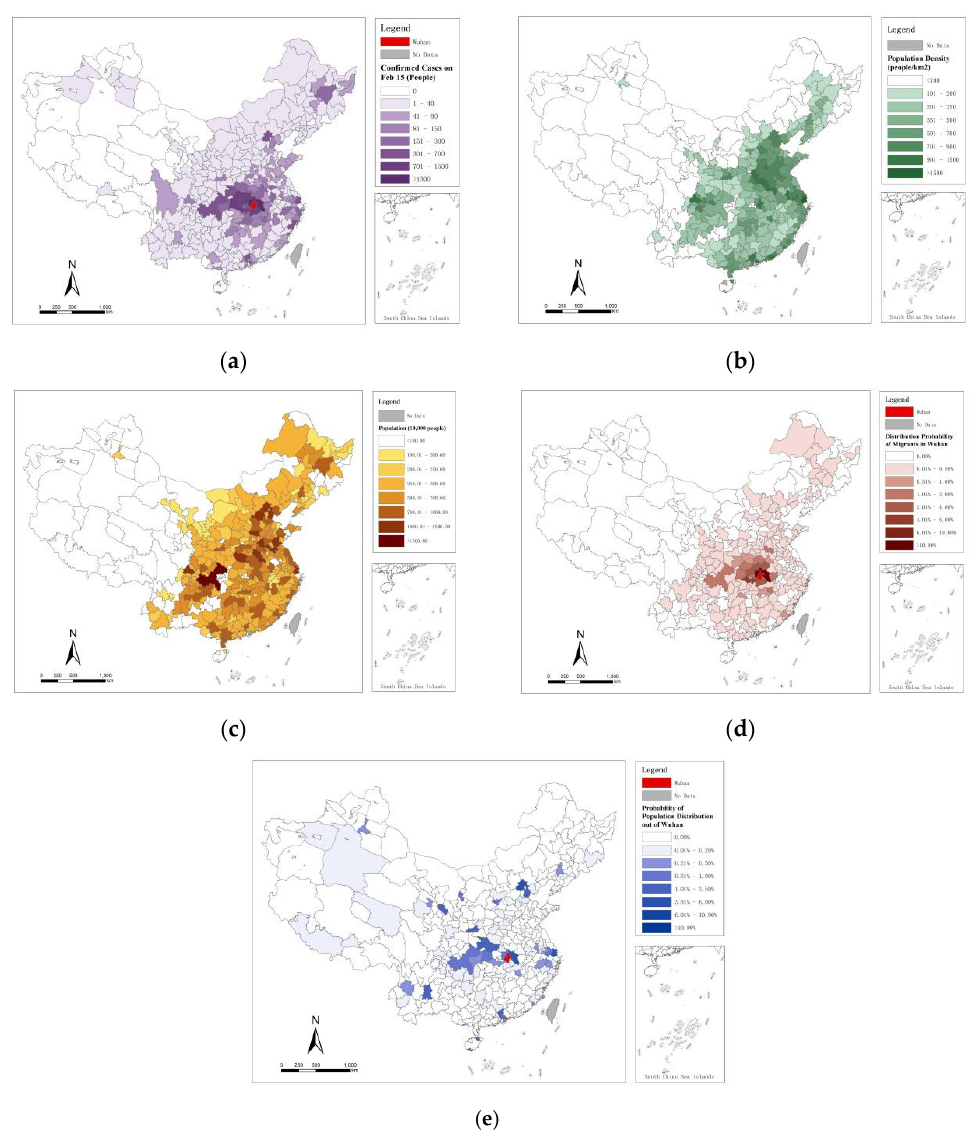
Figure 1. Prefecture-level city-related data. ( a ) (cid:1835) (cid:3024)(cid:3048)(cid:3035)(cid:3028)(cid:3041),(cid:3047),(cid:3037) in February 15, 2020; ( b ) (cid:1842)(cid:1867)(cid:1868)(cid:1830) (cid:3037) ; ( c ) (cid:1842)(cid:1867)(cid:1868) (cid:3037) ; ( d ) (cid:1868) (cid:3050)(cid:3048)(cid:3035)(cid:3028)(cid:3041),(cid:3115)(cid:3382)(cid:4652)(cid:4652)(cid:4652)(cid:4652)(cid:4652)(cid:4652)(cid:4652)(cid:4652)(cid:4652)(cid:4652)(cid:4652)(cid:4652)(cid:4652)(cid:4652)(cid:4652)(cid:4652)(cid:4652)(cid:4652)(cid:4652) ; ( e ) (cid:1868) (cid:3050)(cid:3048)(cid:3035)(cid:3028)(cid:3041),(cid:3115)(cid:4652)(cid:4652)(cid:4652)(cid:4652)(cid:4652)(cid:4652)(cid:4652)(cid:4652)(cid:4652)(cid:4652)(cid:4652)(cid:4652)(cid:4652)(cid:4652)(cid:4652)(cid:4652)(cid:4652)(cid:4652)(cid:4652)(cid:1318)